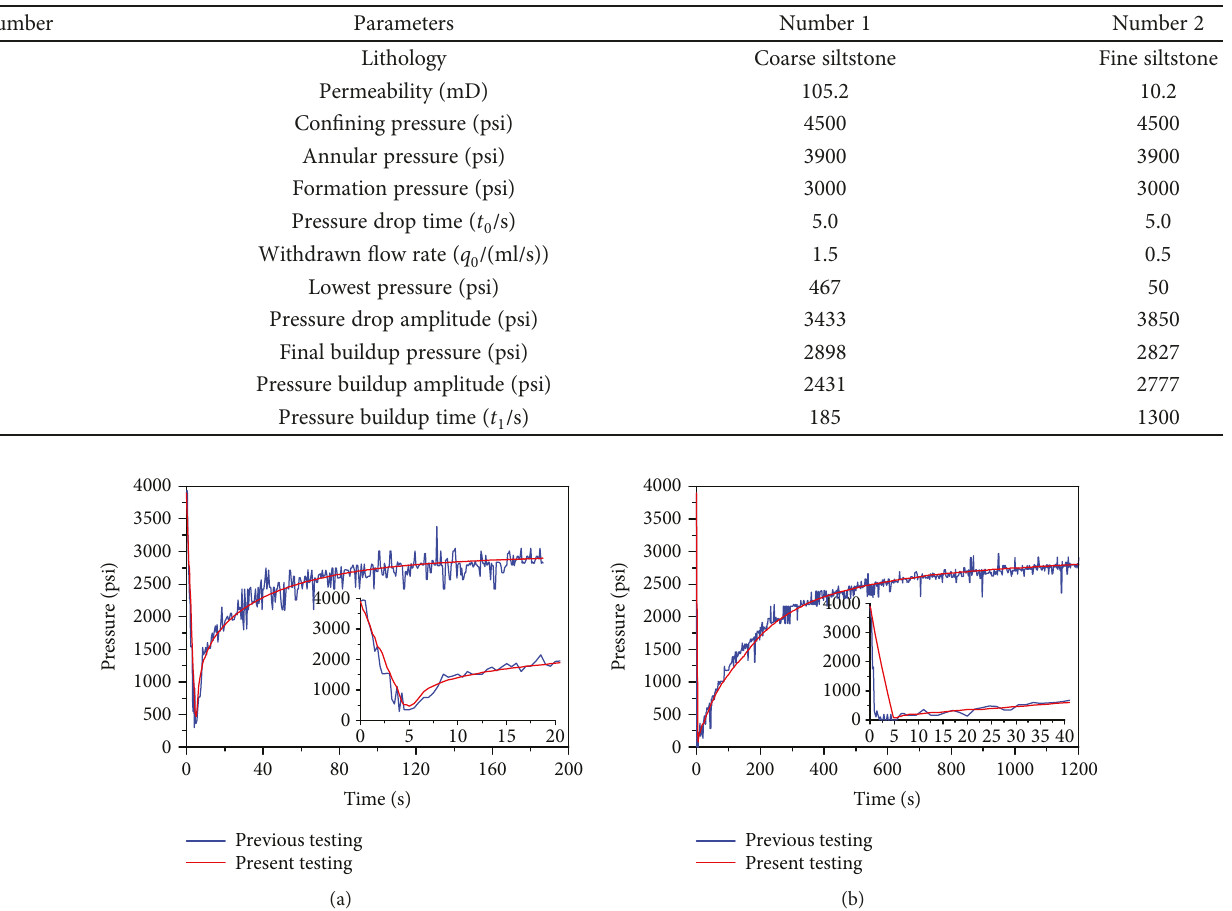
Figure 14: Testing results of pressure response for both the present and the previous systems under di ff erent permeabilities. (a) Pressure response versus time (number 1, k = 105 2 mD, q = 1 5 ml/s, t 0 = 5 s). (b) Pressure response versus time (number 2, k = 10 2 mD, = 5 s). q = 0 5 ml/s, t 0